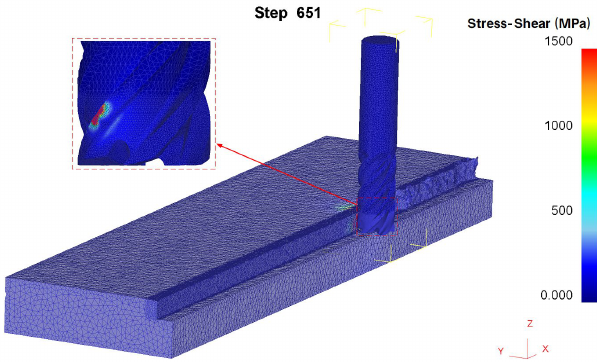
Figure 10. Instantaneous cutting volume of the selected cutting edge point.